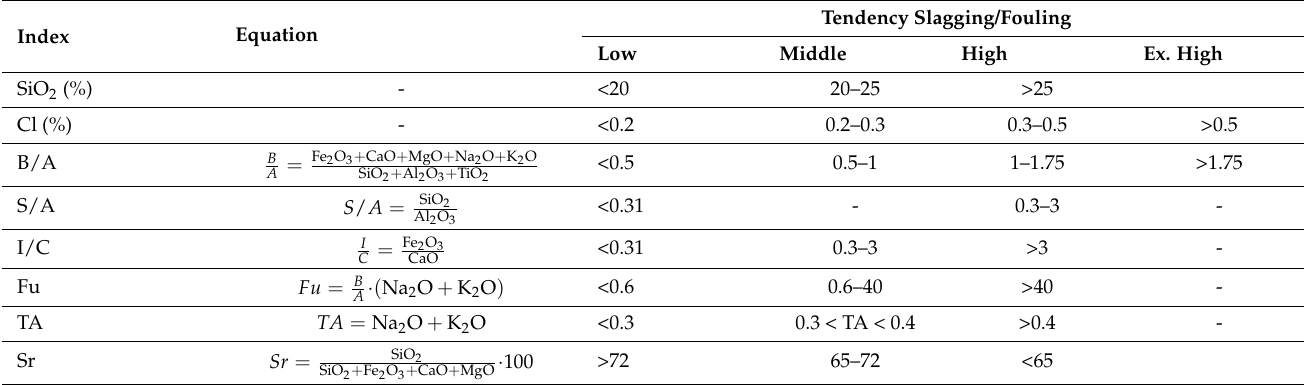
Table 1. Ash characterization indices